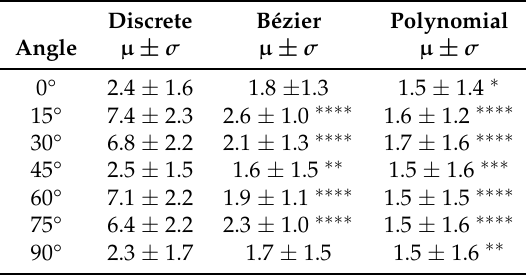
Table 9. Mean relative error of the length measurement methods in % after the centerline extraction by Voronoi diagrams and the spatial interpolation compared to the ground truth for the experimental data set. Significance was proven for the reduction of the error compared to the discrete length as indicated ∗ p < 0.05, ∗∗ p < 0.01, ∗∗∗ p < 0.001, ∗∗∗∗ p <